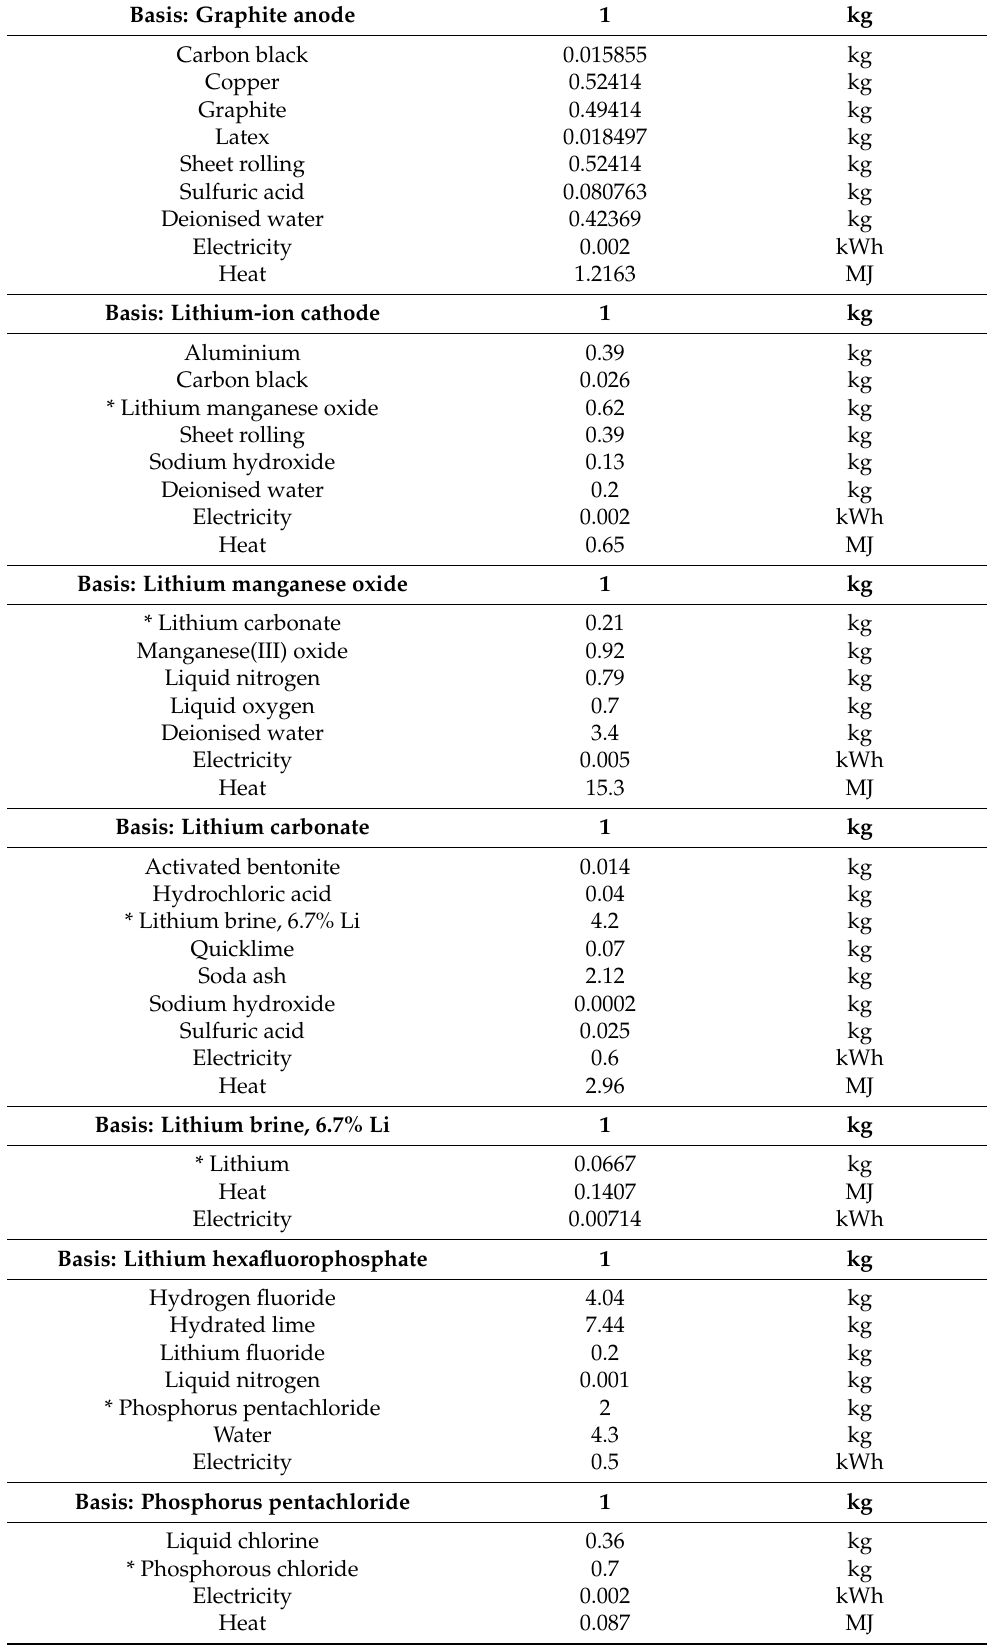
Table 1. Cont. Basis: Graphite